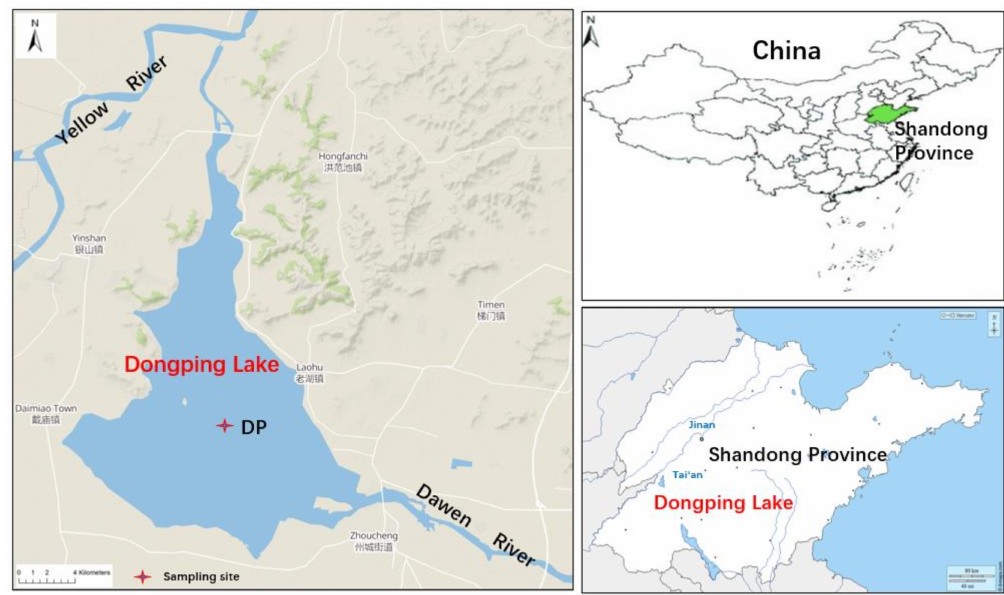
Figure 1. Map of the study area and location of the sampling